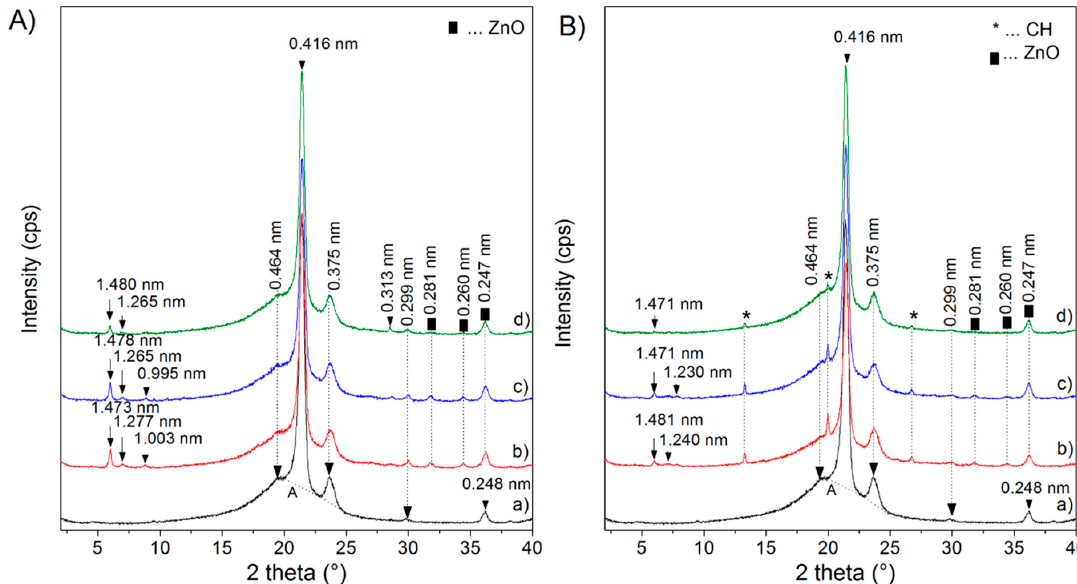
Figure 3. XRD patterns of the low-density polyethylene (LDPE) nanocomposite plates. ( A ): a) LDPE, b) LDPE_5% ZnO/V, c) LDPE_3% ZnO/V, d) LDPE_1% ZnO/V; ( B ): a) LDPE, b) LDPE_5%